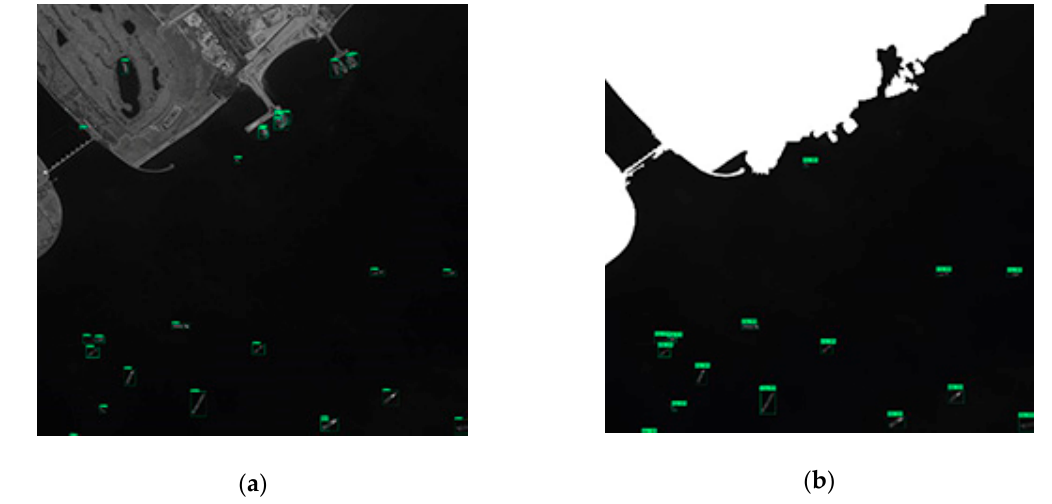
Figure 10. The detection results of the partial region of the GF-2(1) image. ( a ) Test results using network with a proportion of positive to negative samples of 1:1. ( b ) Test results using network with a proportion of positive to negative samples of 1:1 after FCN-based segmentation.